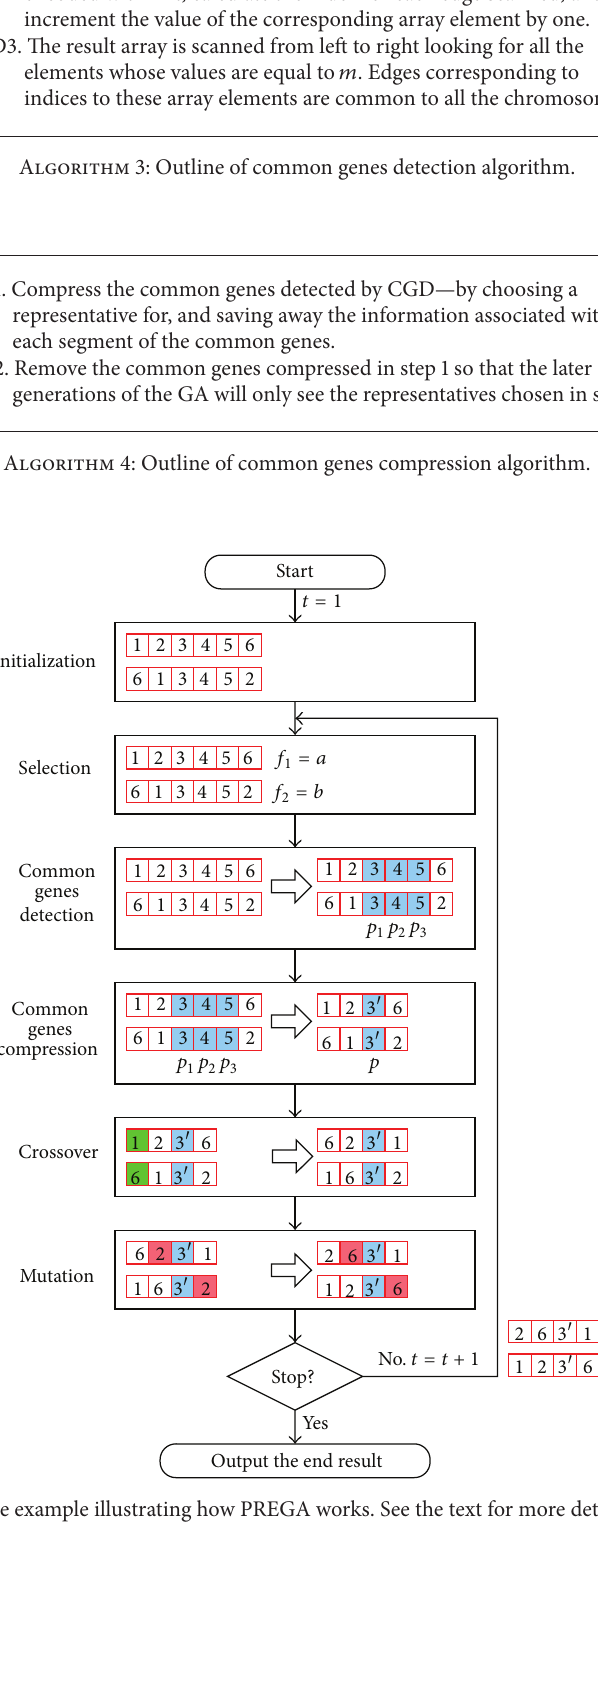
Figure 2: A simple example illustrating how PREGA works. See the text for more detailed